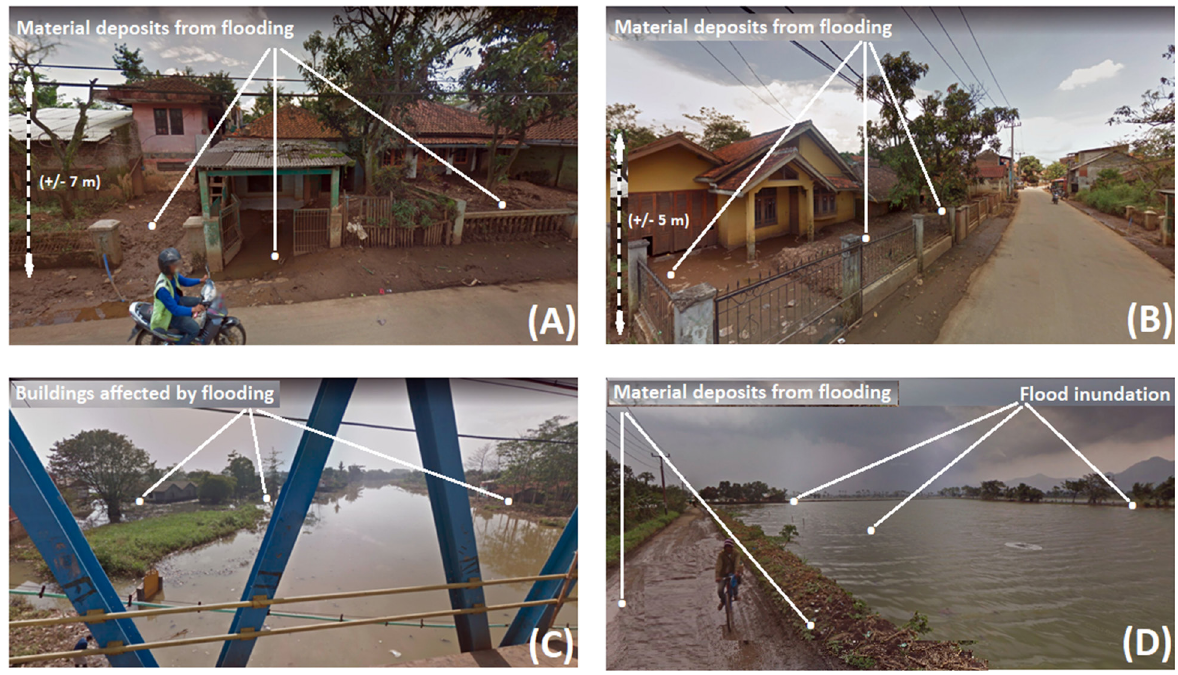
Fig. 11. Areas affected by